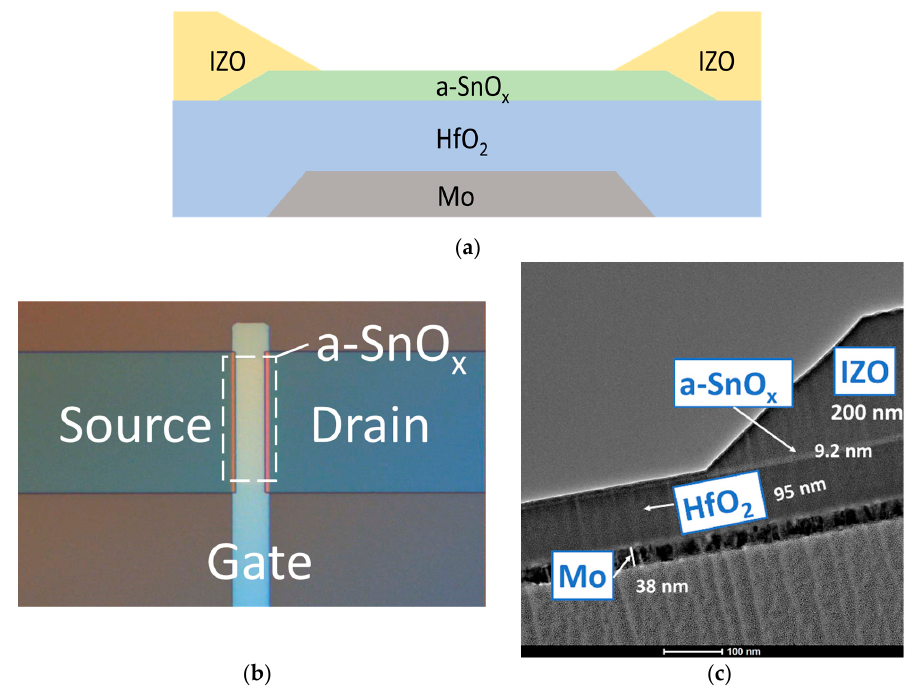
Figure 3. The a-SnO x TFT structure: ( a ) a schematic diagram of the bottom gate and top contact a-SnO x TFT. ( b ) An illustration of an a-SnO x TFT. ( c ) TEM image of an a-SnO x TFT taken near the source/drain region.